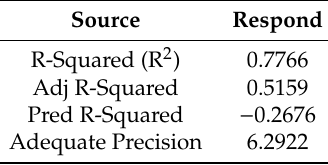
Table 6. The statistical measurement from ANOVA for